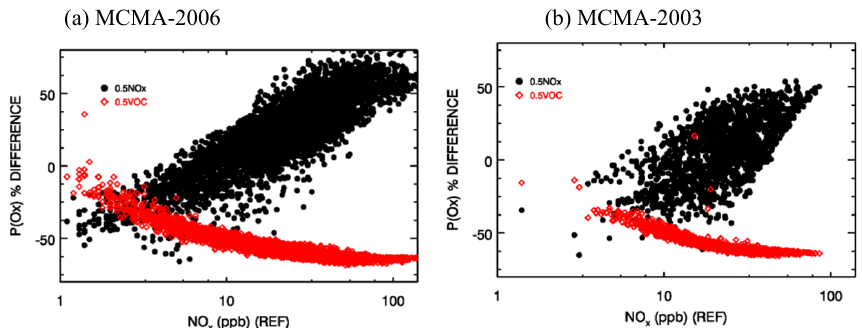
Fig. 14. Simulated percentage change of P(O x ) as a function of base case NO x in the urban area at 12:00–17:00LT during (a) MCMA-2006 and (b) MCMA-2003. Datapoints in (a) include weekdays only throughout the whole episode.